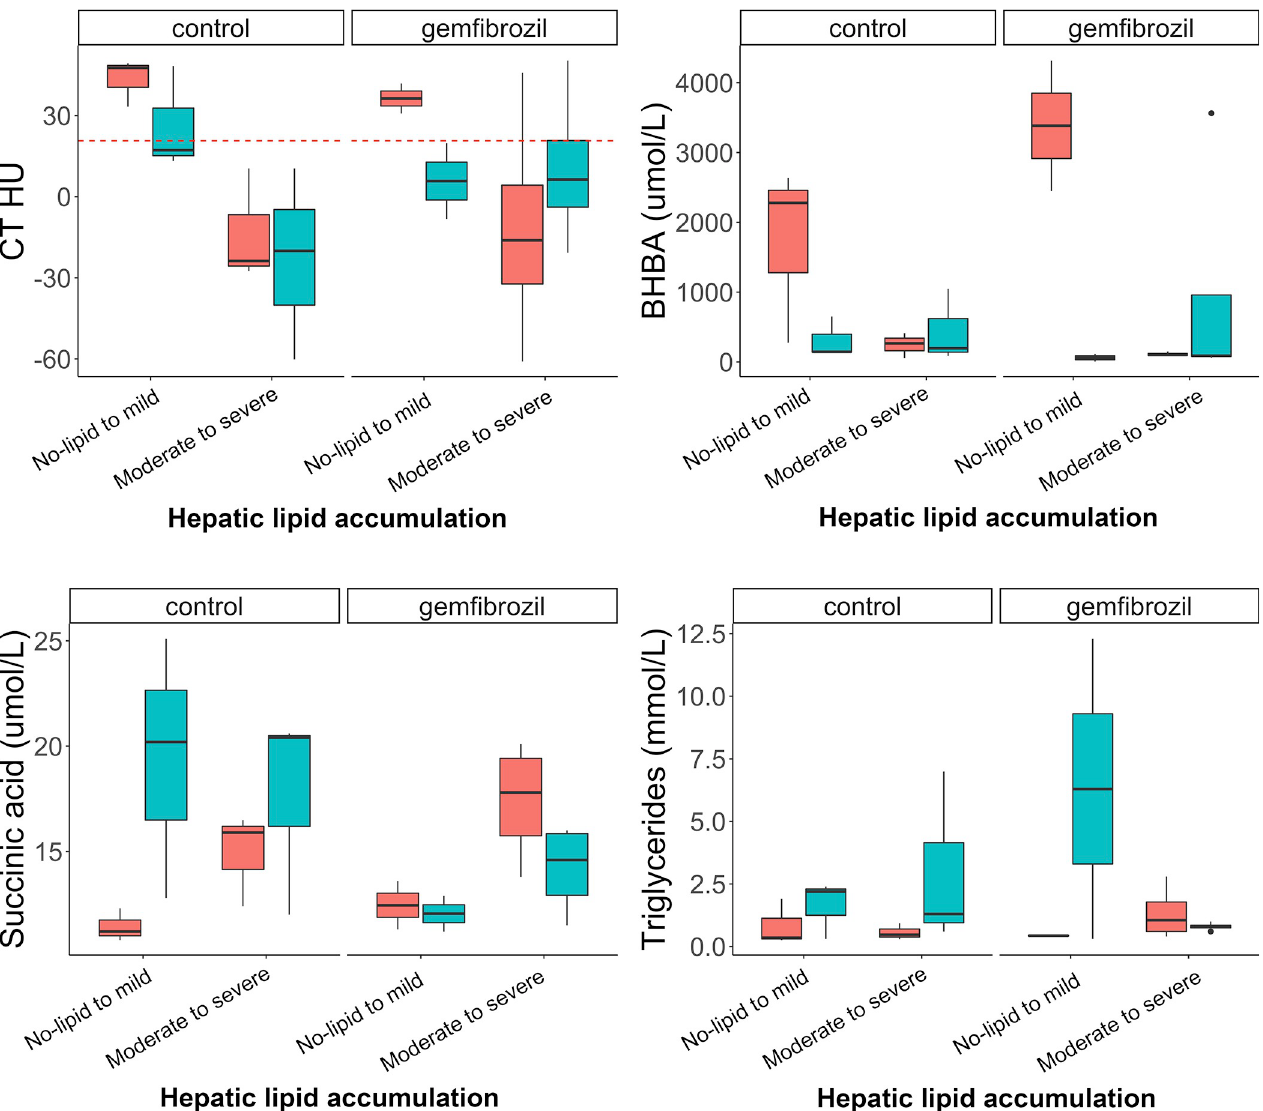
Fig 9. Side-by-side box plots with superimposed dot plots of selected variables (CT [HU], BHBA [umol/L], succinic acid [umol/l], triglycerides [mmol/ L]) across two simplified classes of hepatic lipid changes (no-lipid to mild and moderate to severe), based on an established grading system [30], in bearded dragons with and without (control) gemfibrozil treatment evaluated by t-tests. The red boxplots represent baseline values and the teal represents values after a 2-month treatment trial with gemfibrozil. The dotted red line on the CT HU side-by-side box plot represents a cut-off value of 21 HU to separate the classes of no-lipid to mild and moderate to severe as determined on receiver operating characteristic analysis.There was a significant effect of gemfibrozil on succinic acid. While succinic acid significantly increased over time in the control group, it did not with gemfibrozil treatment. The remainder of the variables were not statistically significant but did show interesting